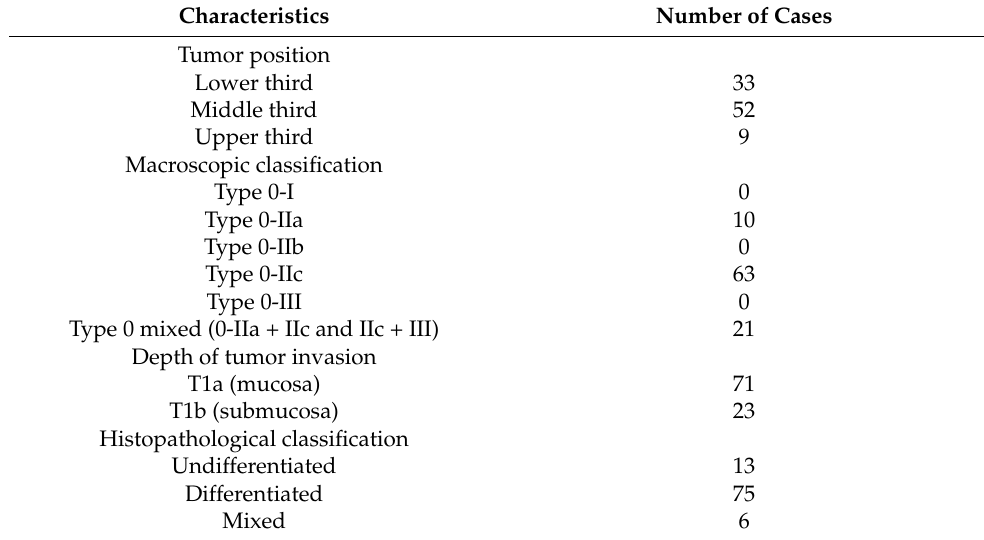
Table 1. Clinical characteristics of gastric cancer lesions in the